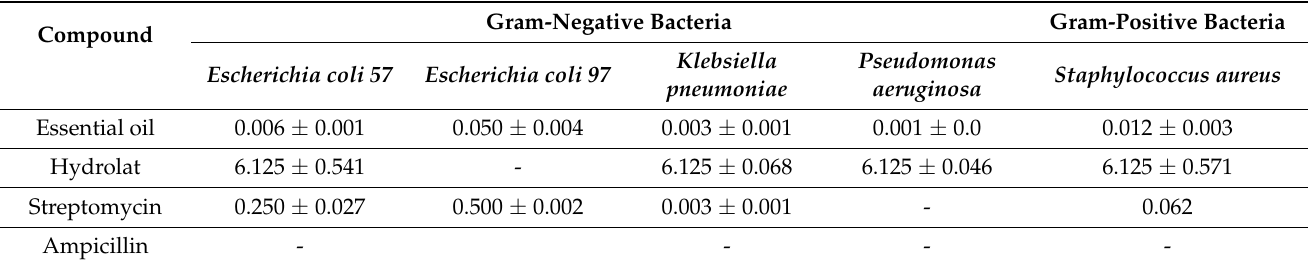
Table 5. Minimum inhibitory concentration of hydrolat and essential oil of W. frutescens (MIC in µ